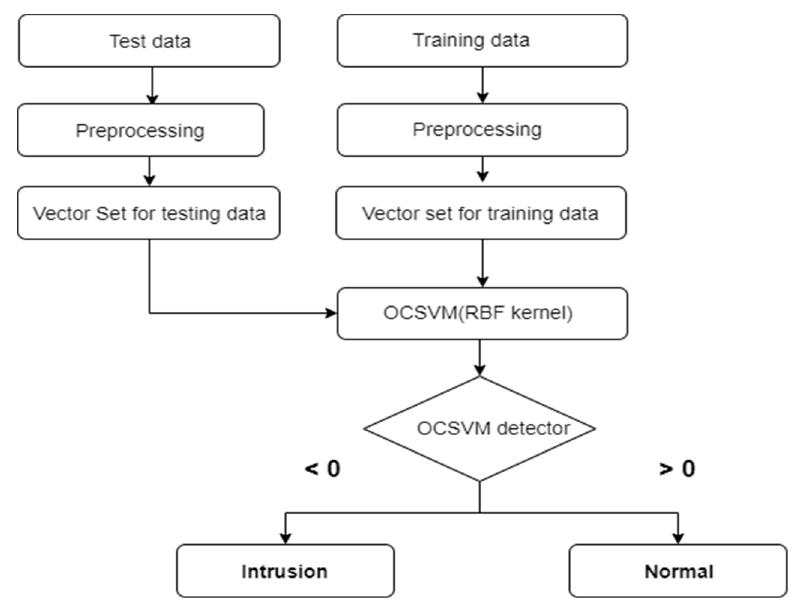
Figure 4. Anomaly-based Intrustion Detection System ( AIDS) based one-class svm.